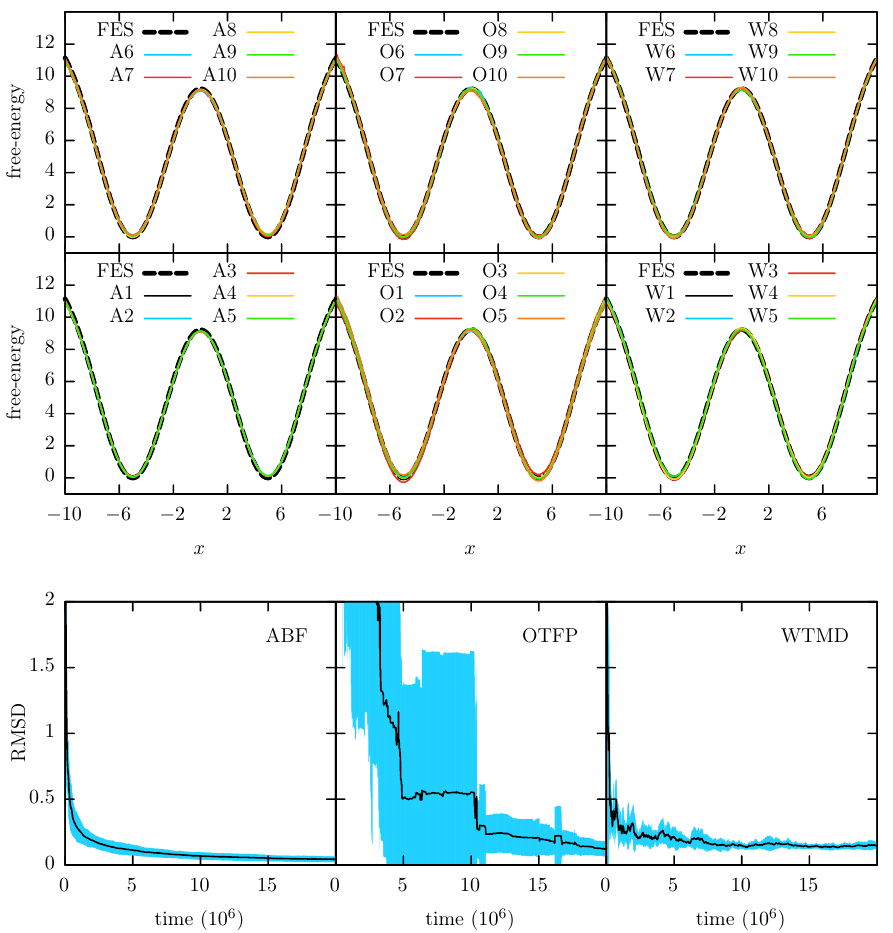
Figure 3. FEPs obtained using x as CV and 10 different simulations for each free energy method as indicated: A1–A10 for ABF, O1–O10 for OTFP and W1–W10 for WTMD. The dashed lines correspond to the FEP computed via a direct (numerical) integration of Equation (1). The average convergence profiles are also shown in the bottom of the figure. The light blue region corresponds to one standard deviation. This profiles shows the expected convergence of each individual simulation and should not be confused with the convergence of the average FEP profile. For the average FEP and the individual convergence profiles see Figure S7 in the Supplementary